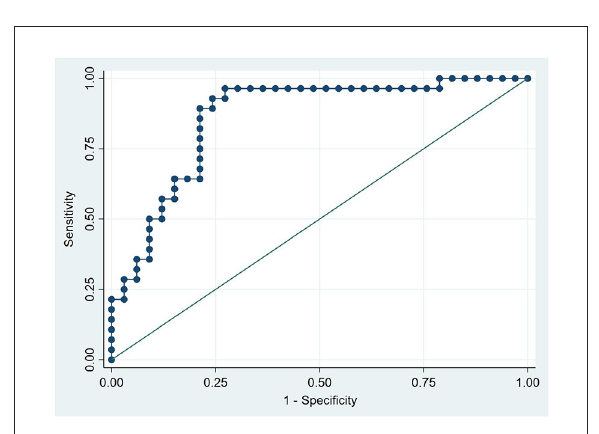
FIGURE4 ROC curve analysis for the plasma PAGln level in predicting ISR. The AUC was 0.861 (95% CI 0.766–0.957, P < 0.001).